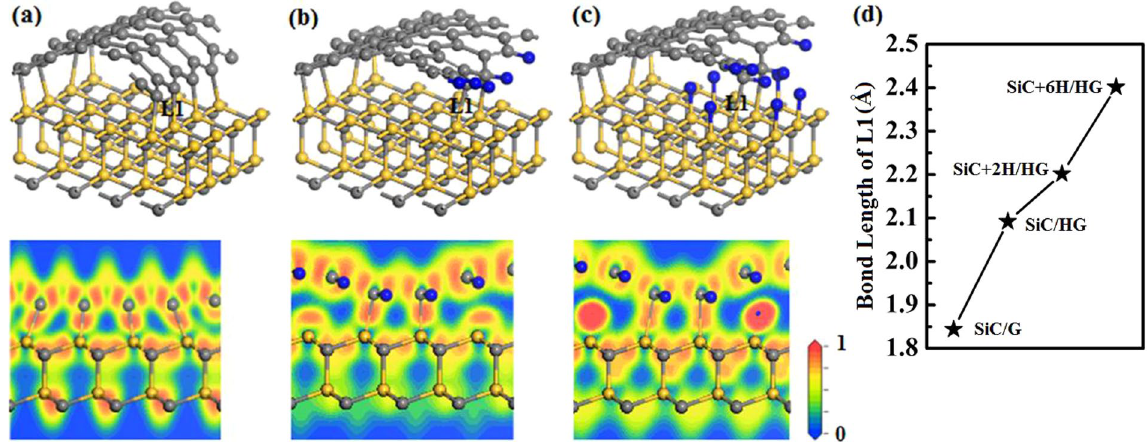
Figure 5. Atomic structures (upper panels) and ELFs (lower panels) of SiC/G ( a ), SiC/HG ( b ) and SiC + 6 H/ HG ( c ), respectively. ( d ) Variation of bond length L1 versus H passivation. (SiC + 2 H/HG means two H atoms adsorb on the interface